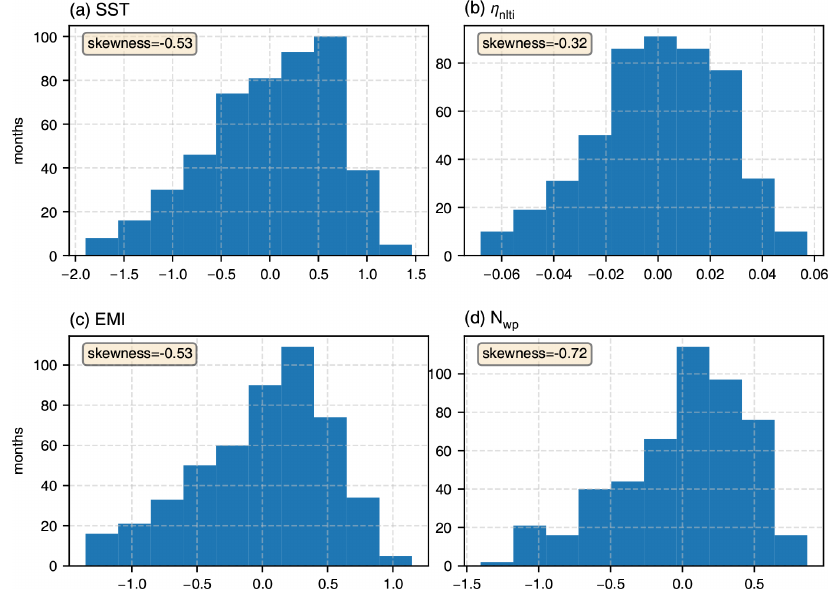
Figure 4. Histograms of the different indices shown in the upper panel of Table 2 and based on the NEMO model simulation. In each case, the range of values has been divided into 10 bins and the number of months in each bin is indicated by the axis on the left. The tail to the left in each case is an indication of negative skewness.